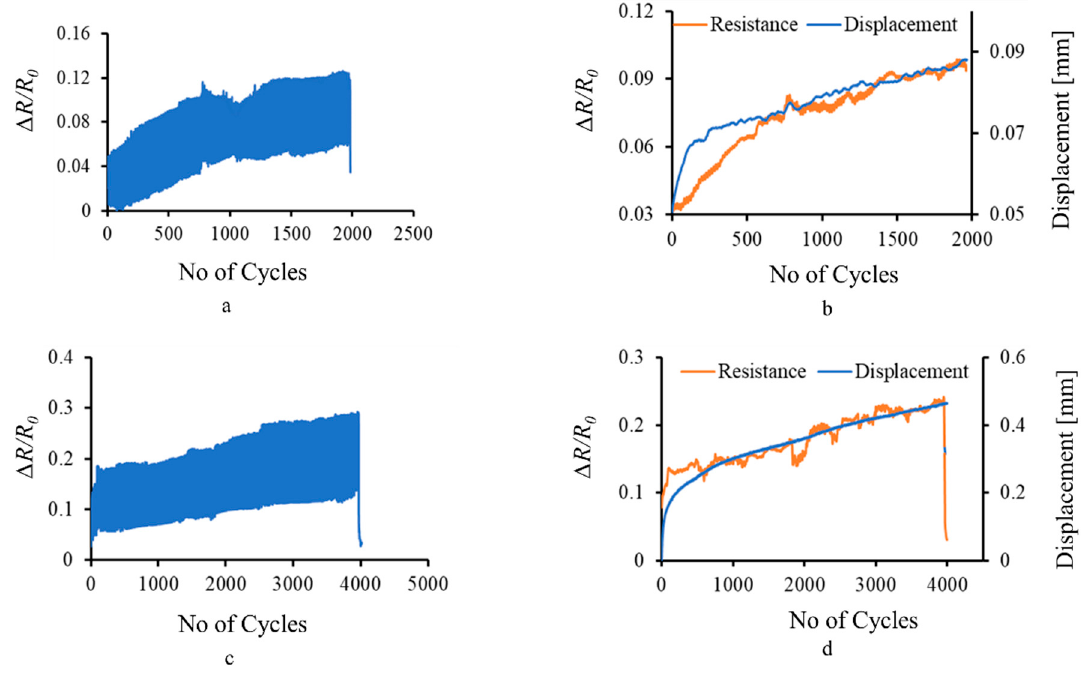
Figure 5. Real-time fatigue sensing of composite T-profile by MXene coating: ( a ) resistance measure- ment at 50 N–0.5 Hz; ( b ) sensing of displacement component during fatigue loading of 2000 cycles; ( c ) resistance measurement at 100 N–1 Hz; ( d ) sensing of displacement component during fatigue loading of 4000